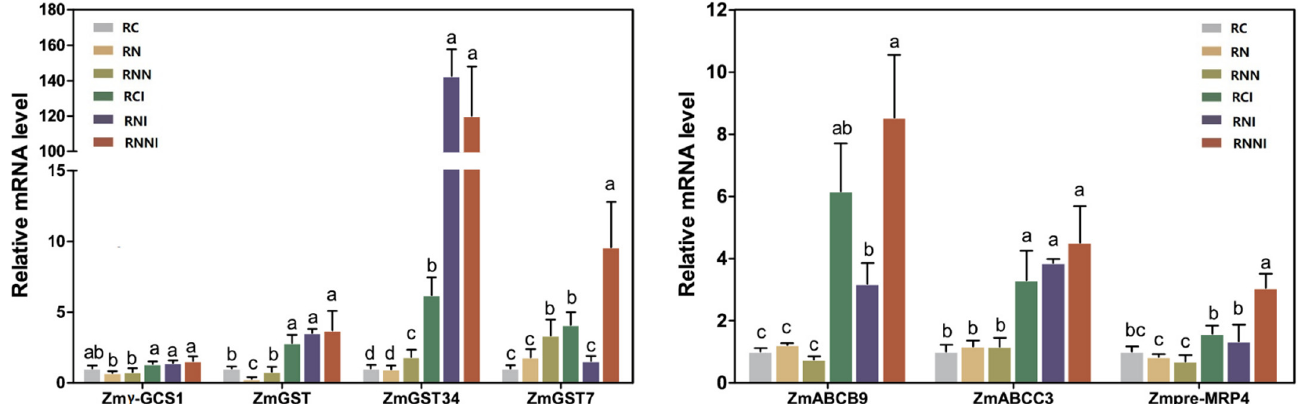
Figure 8. The expression of genes related to stress response. The relative mRNA levels of several genes related to stress responses under 5 ppm IMI treatment, for 24 h, in roots. Lower case letters indicate significant differences among treatments.